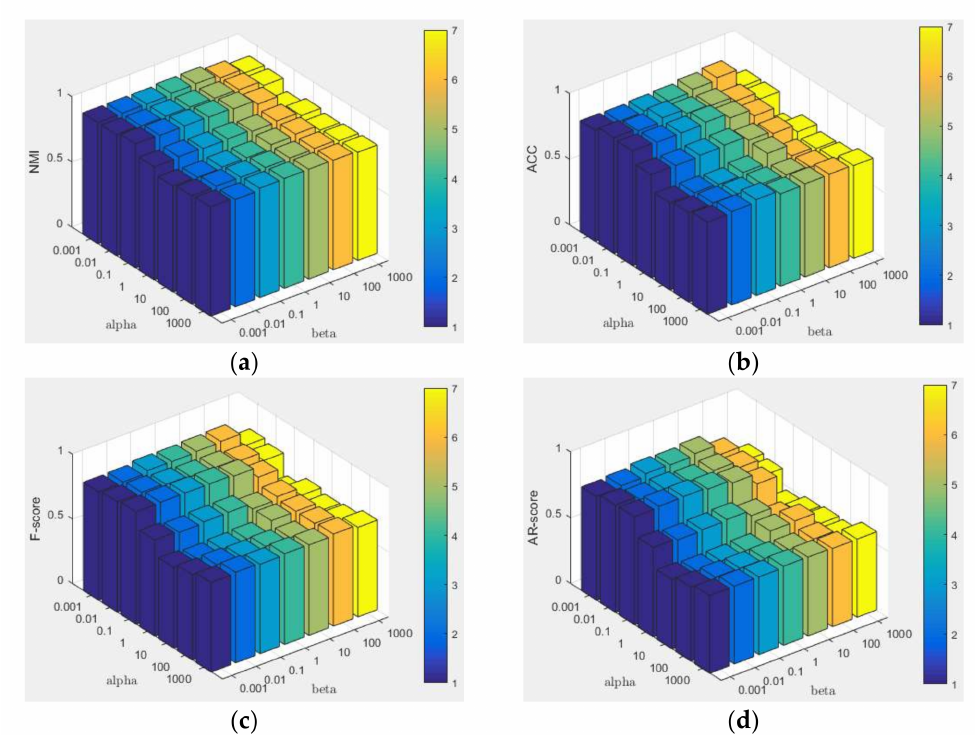
Figure A2. Sensitivity test on alpha and beta versus four metrics on ORL. ( a ) NMI, ( b ) ACC, ( c ) F-score, ( d ) AR.